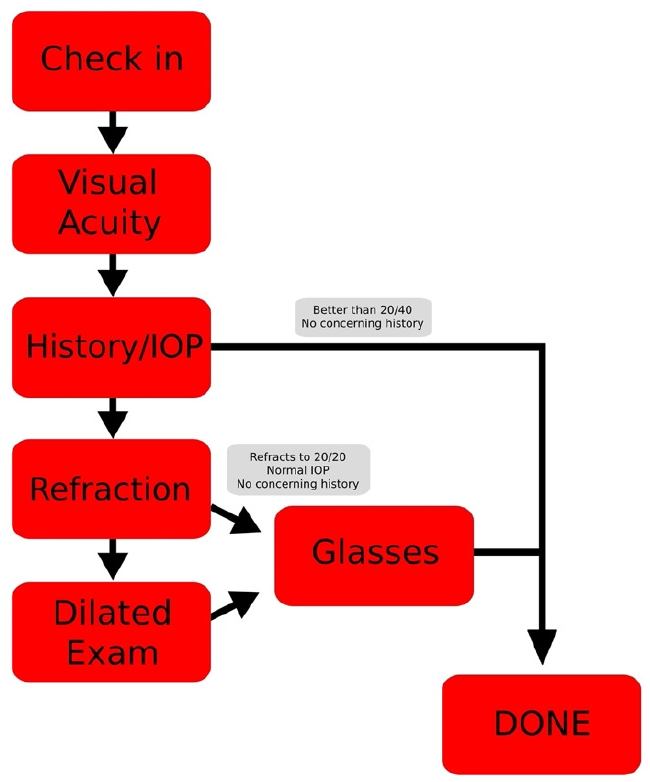
Figure 1. Outreach clinic layout and services .